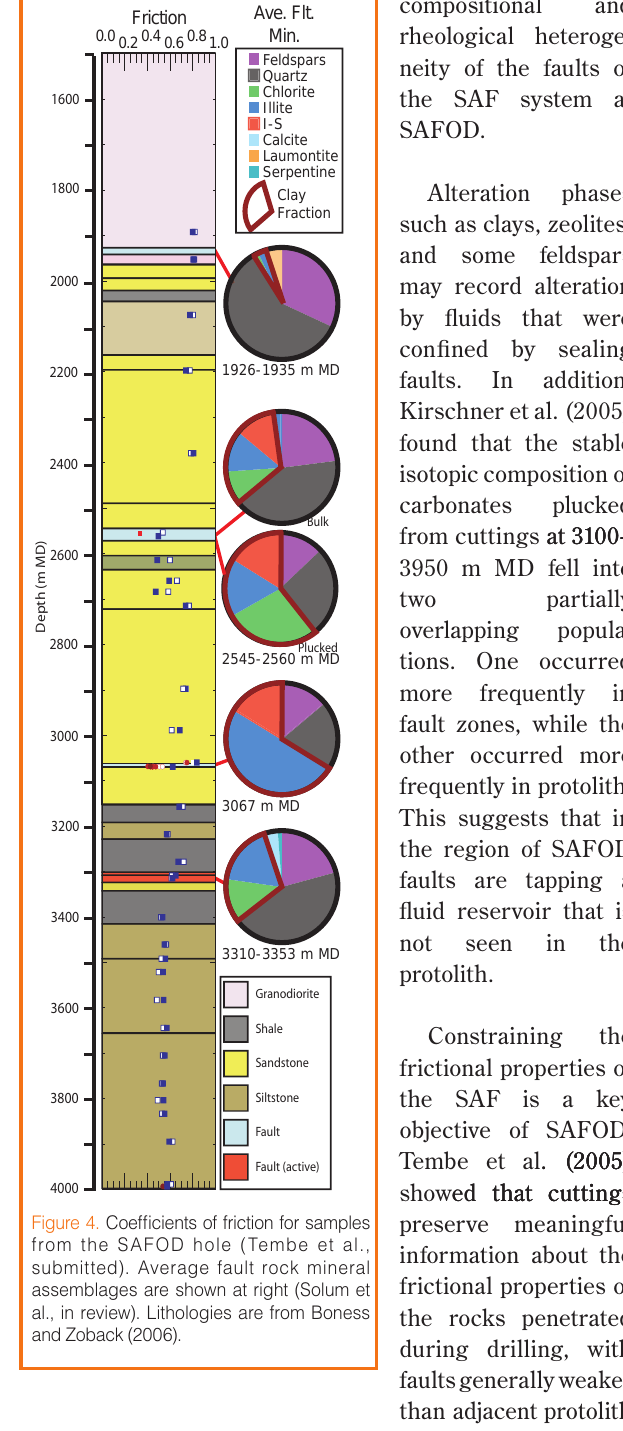
( µ= 0.40–0.55 vs.0–0.55 vs.–0.55 vs. µ= 0.55–0.80). Plucked grains of clay-rich0). Plucked grains of clay-rich). Plucked grains of clay-rich fault rocks from 2556 m MD have µ =0.33, while bulk samples from that depth have µ ≈0.45. This indicates that analyses of bulk samples provide an upper bound on the coefficient of friction, and that the properties of fault rocks can be better constrained by plucking grains of fault rocks from bulk cuttings. Analyses of plucked fault rocks from the section of the hole that contains the actively creeping fault are ongoing.